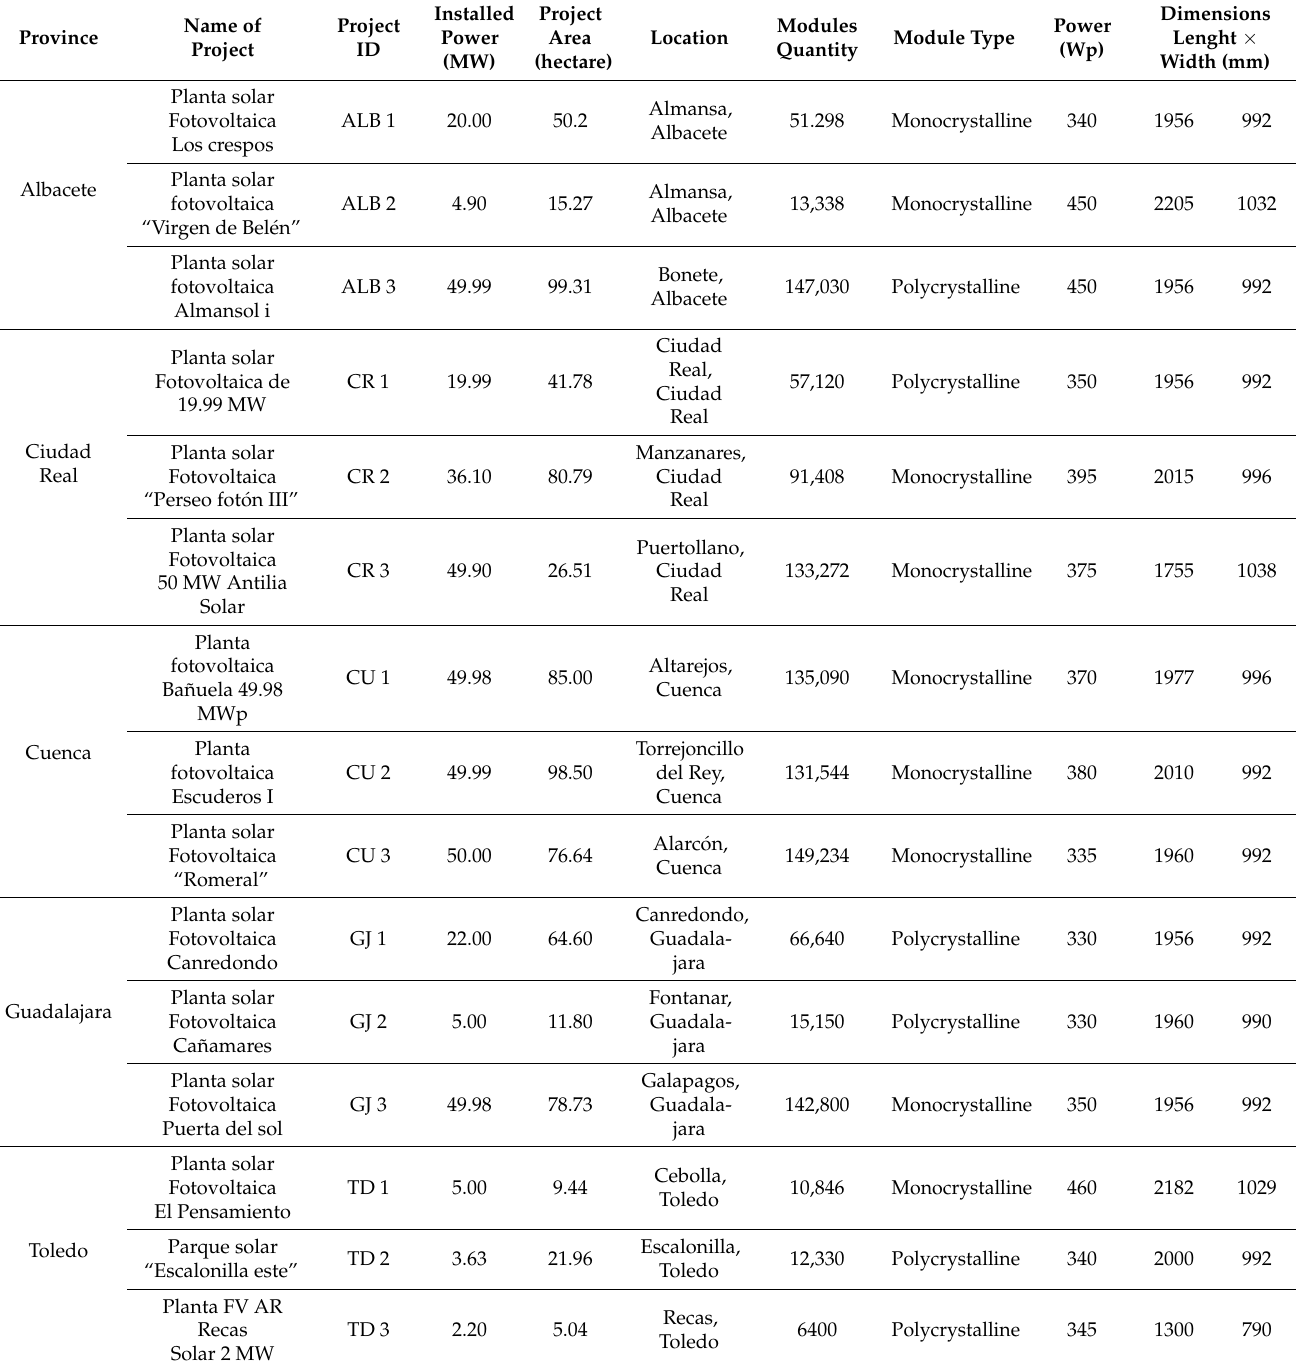
Table A1. Description of the selected Photovoltaics Power Plants from the Castilla—La Mancha